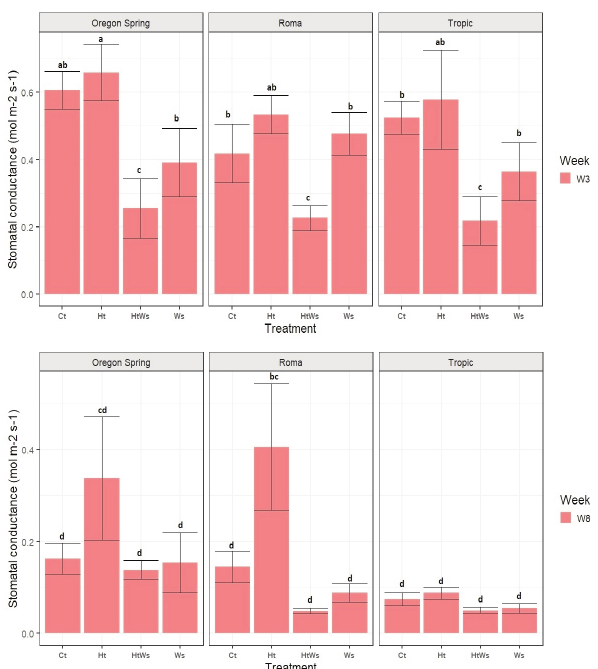
test.Fig. 3 ­ Stomatal conductance (mol m ­2 s ­1 ) of the three tomato varieties (Oregon Spring, Roma and Tropic). The treat­ ments consist of Control (Ct), Water stress (Ws), Heat + Water stress (HtWs) and Heat (Ht). W3 and W8 = weeks of treatments imposition with measurements. Bars with the same letter are not significantly different at P<0.05 according to Turkey's